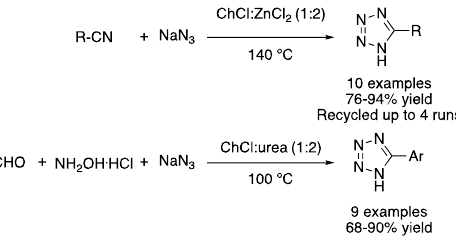
Figure 10. Tetrazole syntheses through [3 + 2] cycloadditions.